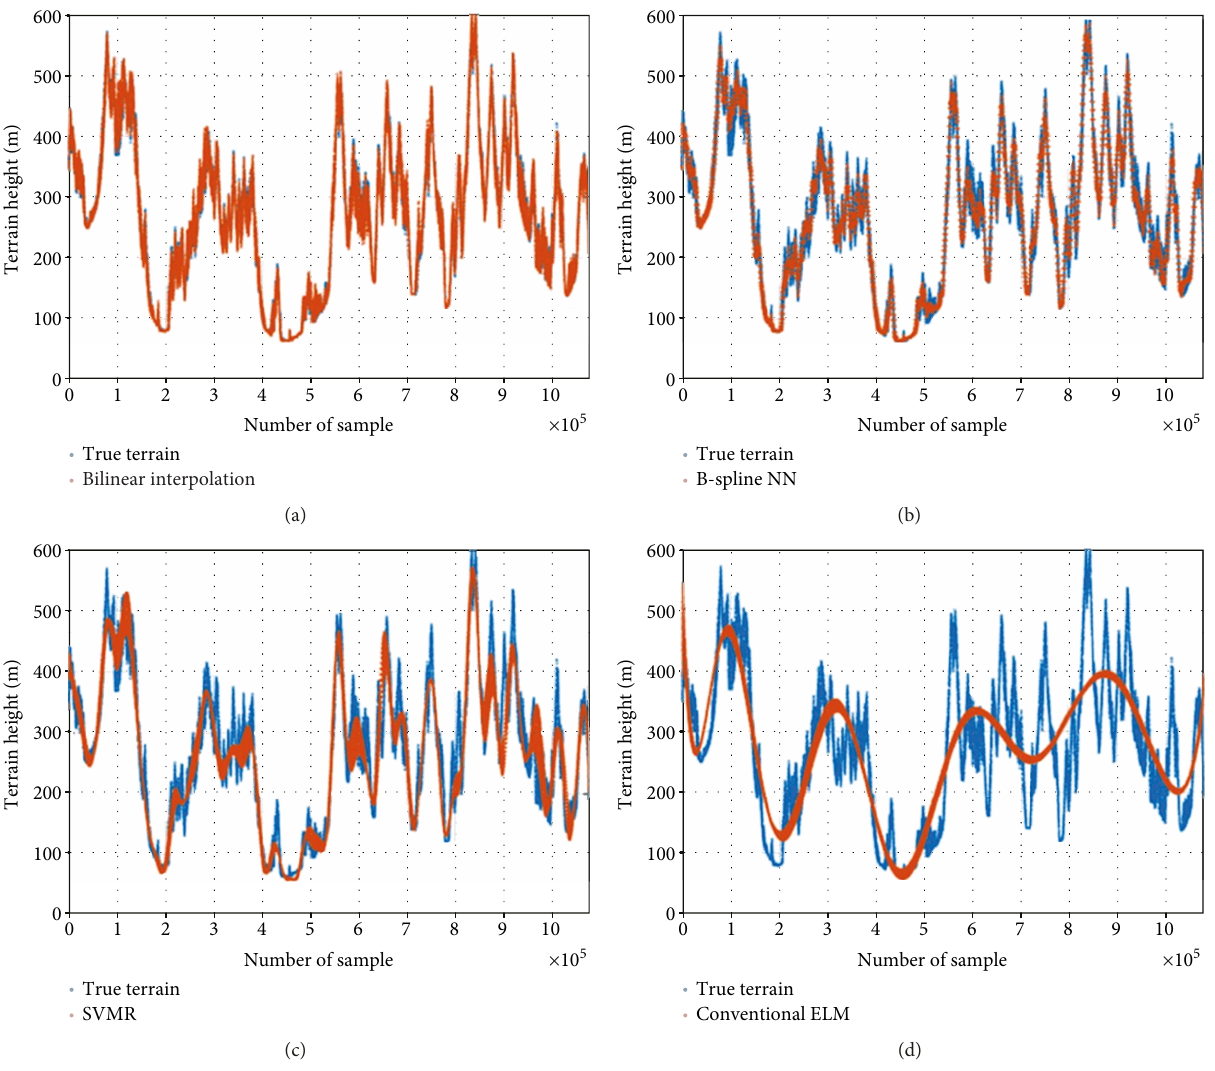
Figure 4: Results of the DEM fi tting methods using DTED level 3. (a) Bilinear interpolation. (b) B-spline neural network. (c) SVMR. (d) Conventional